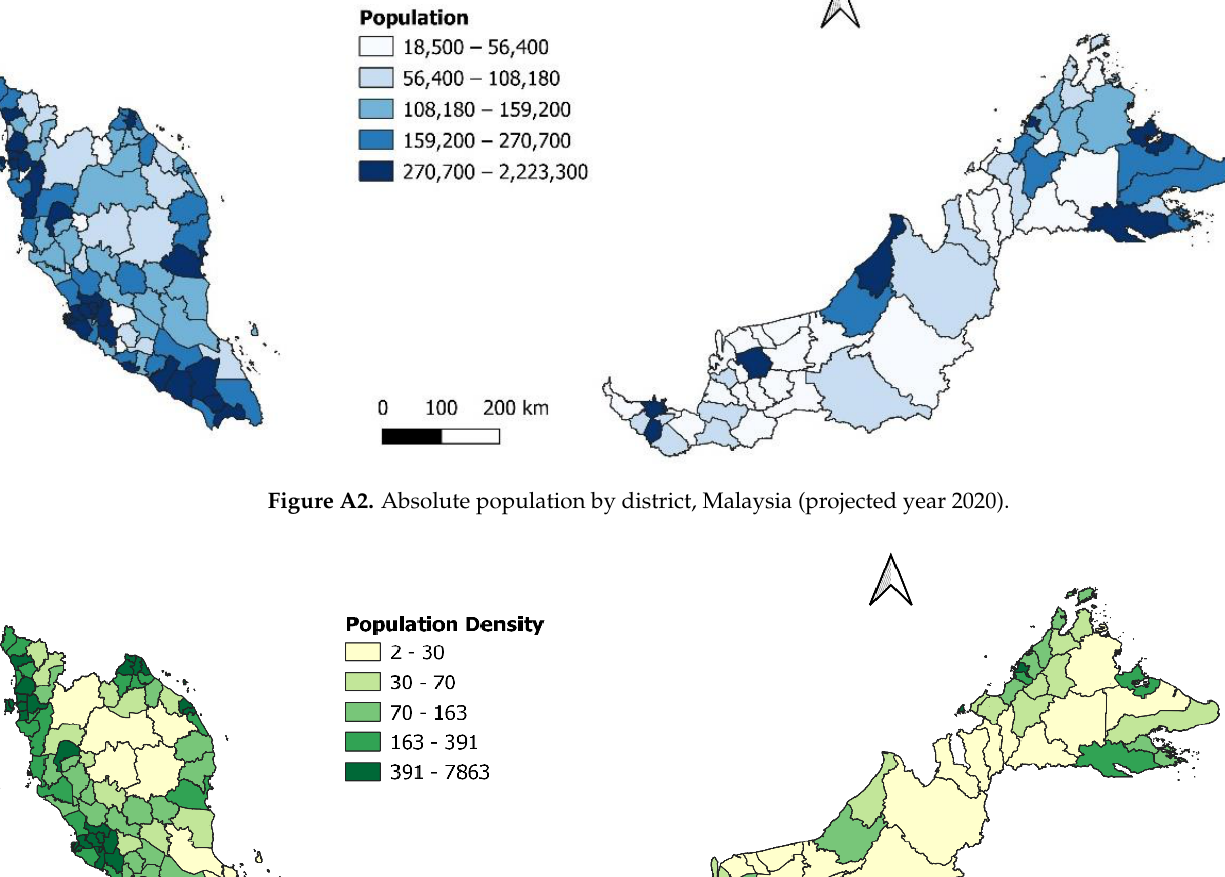
Figure A1. Normal P – P Plot, ( a ) Population, ( b ) Density, ( c ) COVID-19 cases during pre-Delta variant, ( d ) Delta variant period, ( e ) Overall period.